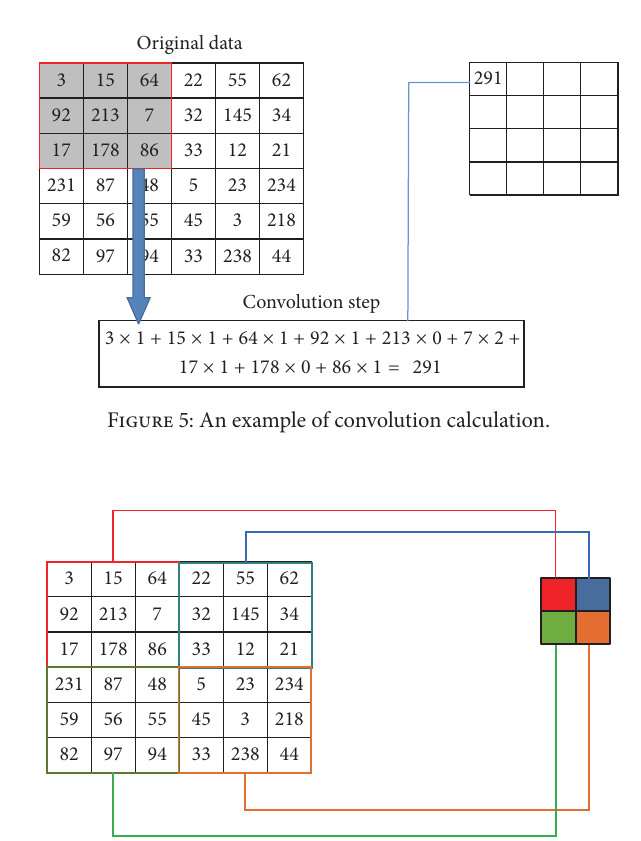
Figure 6: The example of the subsampling